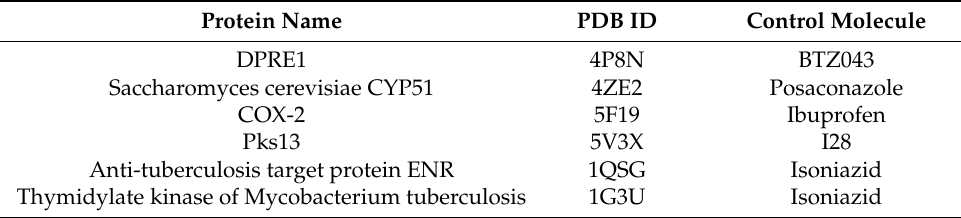
Table 7. Protein names, the related PDB ID, and their control molecules for docking